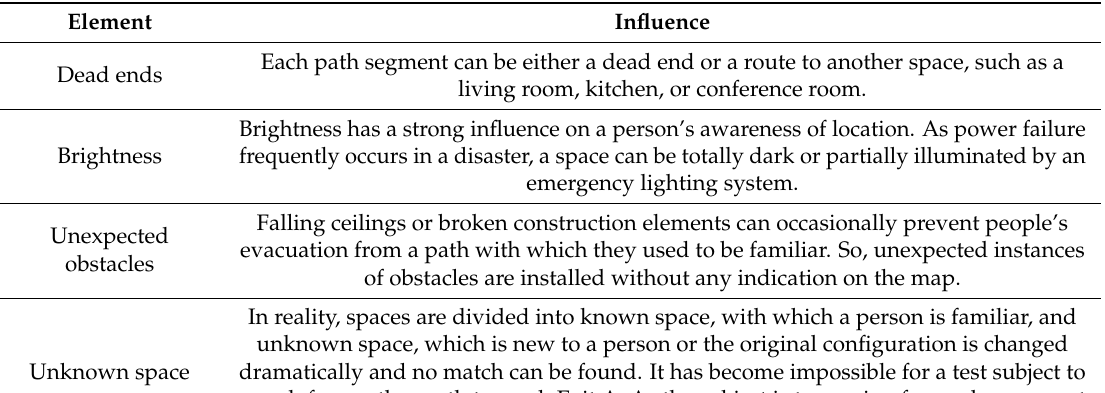
Figure 5. Panoramic view ( left ) and scene inside of the maze ( right ). Table 1. Maze elements and related influence.